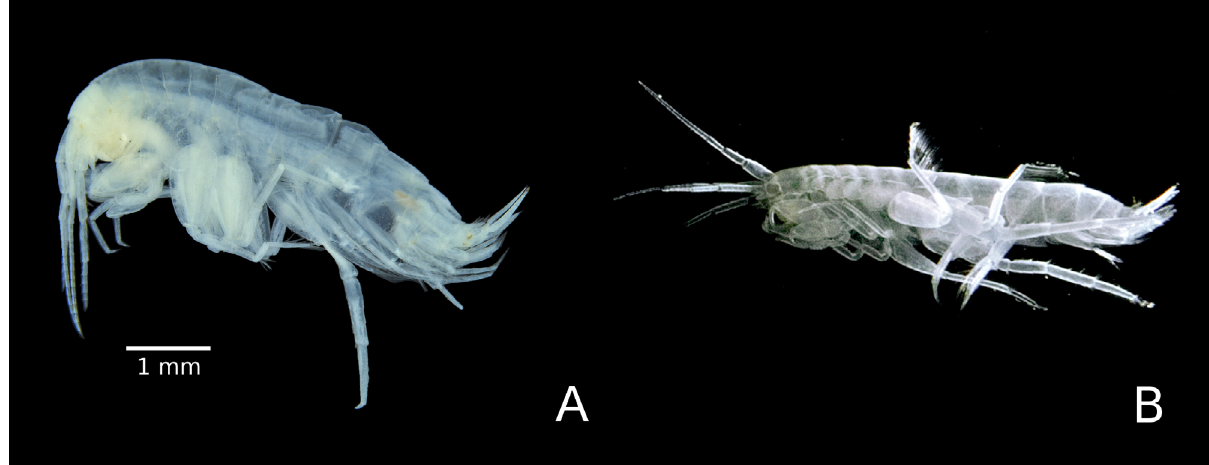
Figure 6. Preserved specimen of Spelaeogammarus spinilacertus Koenemann and Holsinger, 2000 from Buraco do Cão cave, Iraquara municipality, state of Bahia, Brazil ( A ) and live specimen of S. spinilacertus from Canoa Quebrada cave, municipality of Iraquara, state of Bahia, Brazil ( B ). Photograph: ( A ) Luciana B.R. Fernandes, ( B ) Adriano